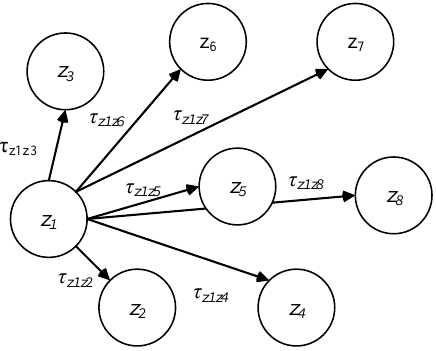
Figure 3. Resource allocation communication graph between nodes.